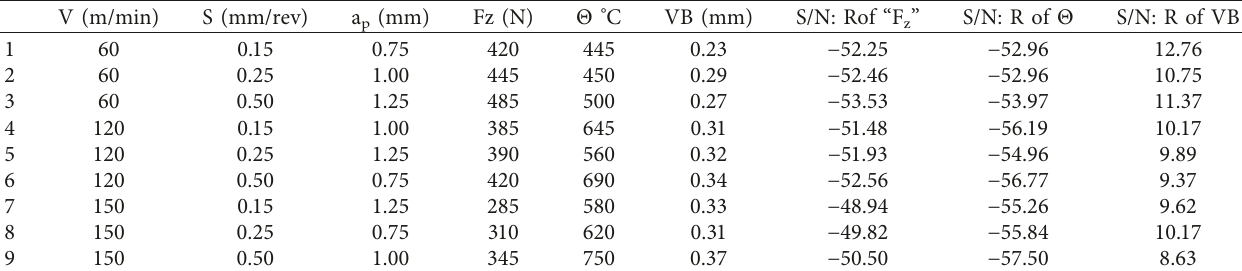
Figure 4. The large signal-to-noise ratio is considered for minimizing the output, and level 3, level 1, and level 3 with respect to speed (150 m/min), feed rate (S: 0.15 mm/rev), and